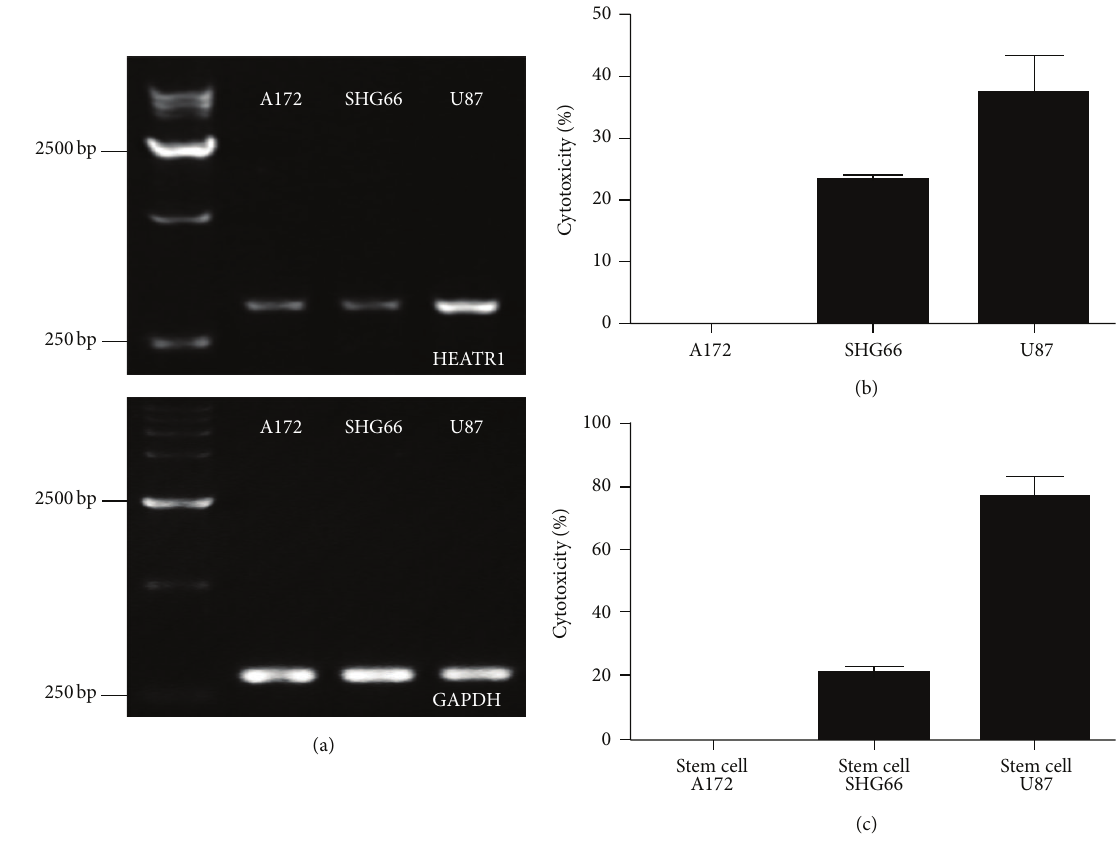
Figure 5: HEATR1-specific-peptide CTLs kill HLA-A ∗ 02+ gliomas that express HEATR1. (a) RNA was isolated from three GBM cell lines and mRNA expression of HEATR1 was investigated by RT-PCR. (b) The values shown represent the mean ± SD of triplicate assays from PBMCs of patient number 323. U87, SHG66, and A172 were loaded with or without peptides and used as target cells in a LDH-release assay. The results showed that 6-peptides-stimulated PBMCs significantly lysed U87 and SHG66 target cells expressing both HEATR1 and HLA- A ∗ 02 but not A172 cells that do not express HLA-A ∗ 02 at an E/T ratio of 10: 1. (c) Six-peptides-stimulated PBMCs from patient number 323 also significantly lysed the U87 and SHG66 GSCs at an E/T ratio of 10: 1. Statistical differences between two groups were evaluated by the unpaired Student’s 𝑡